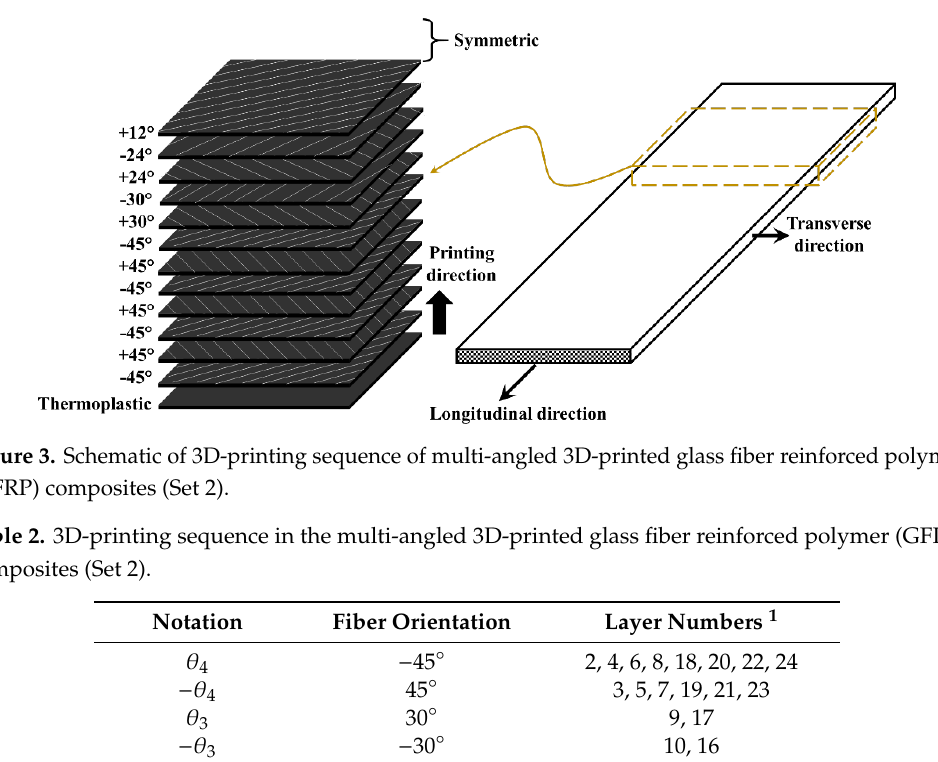
Table 2. 3D-printing sequence in the multi-angled 3D-printed glass fiber reinforced polymer (GFRP) composites (Set 2).